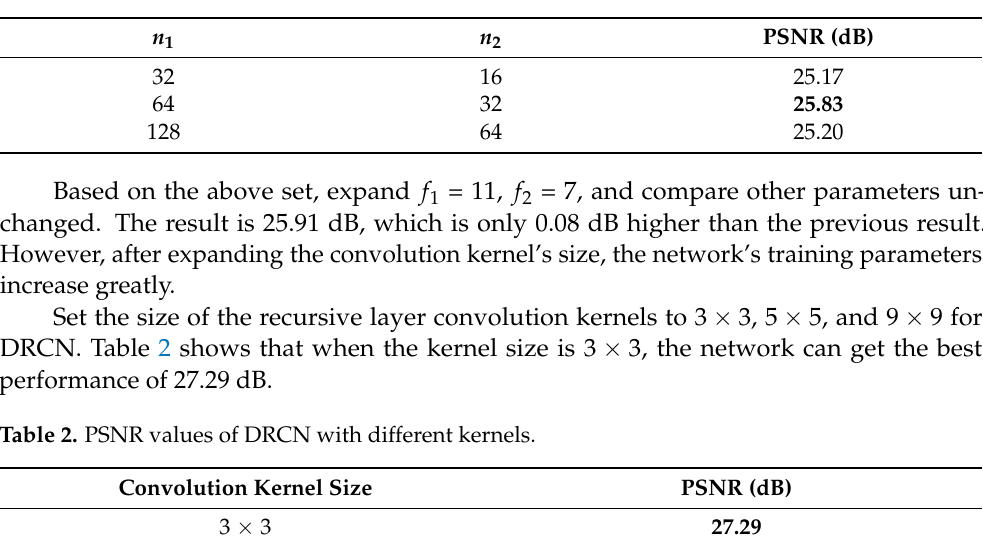
Figure 6. Training dataset. Table 1. Comparison of PSNR values of SRCNN reconstruction. Results with different numbers of convolution kernels.